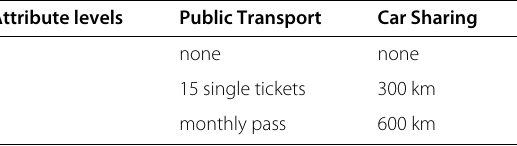
Table 1 Attributes and levels of service Attribute